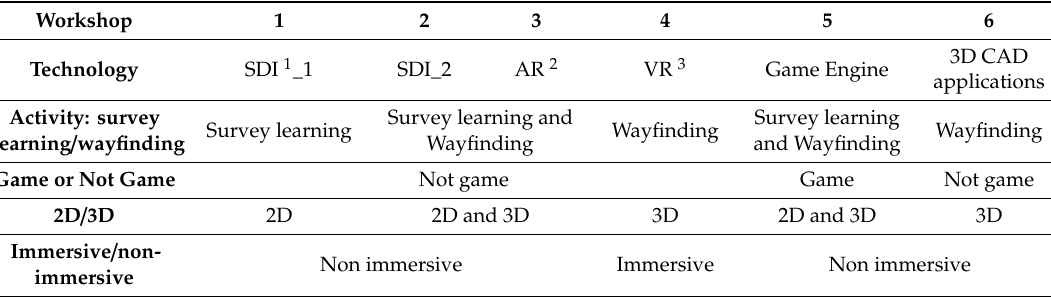
Table 1. Classifications of the